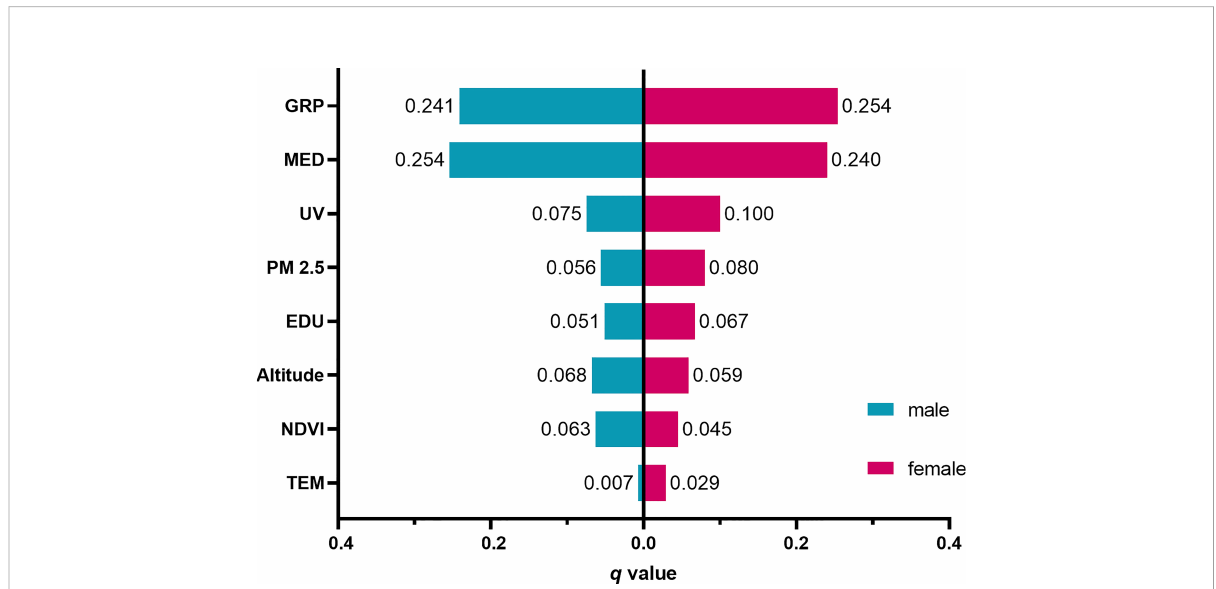
FIGURE 3 Results of the factor detector by gender. GRP, gross regional product per capita; MED, medical level; UV, ultraviolet radiation; PM2.5, fi ne particulate matter; EDU, education level; NDVI, normalized difference vegetation index; TEM, temperature.